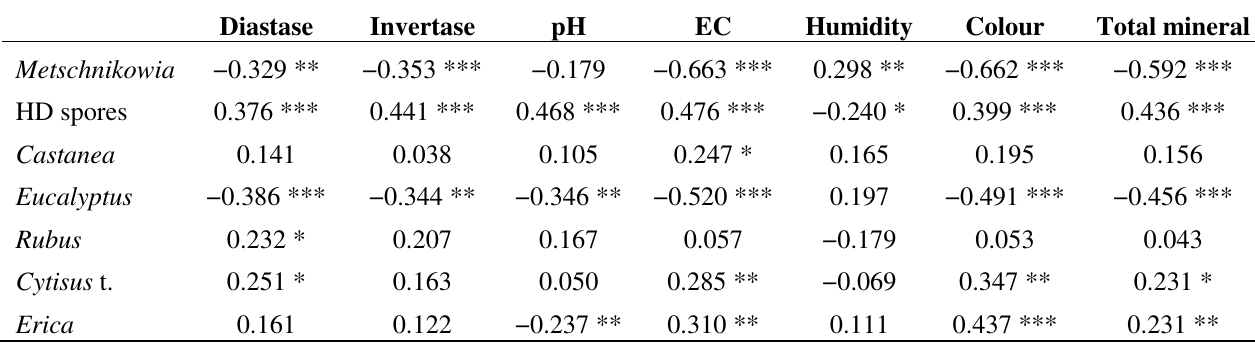
Table 5. Significant correlation coefficients among the microscopic analysis and physicochemical parameter variables, based on Spearman’s